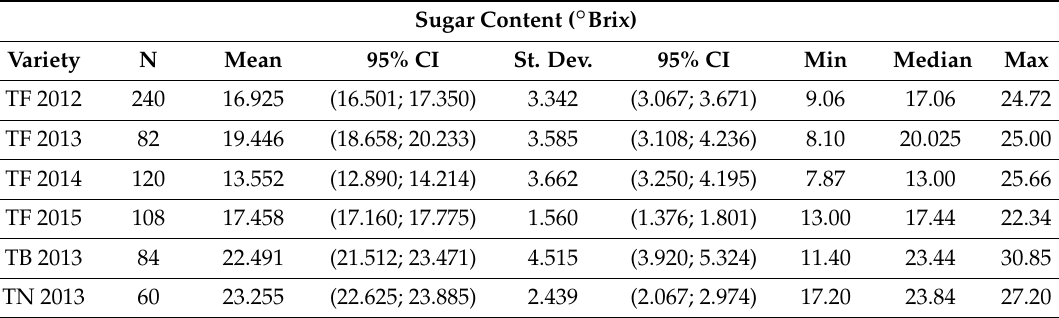
Table A3. Descriptive statistics for the sugar content of the laboratory results.